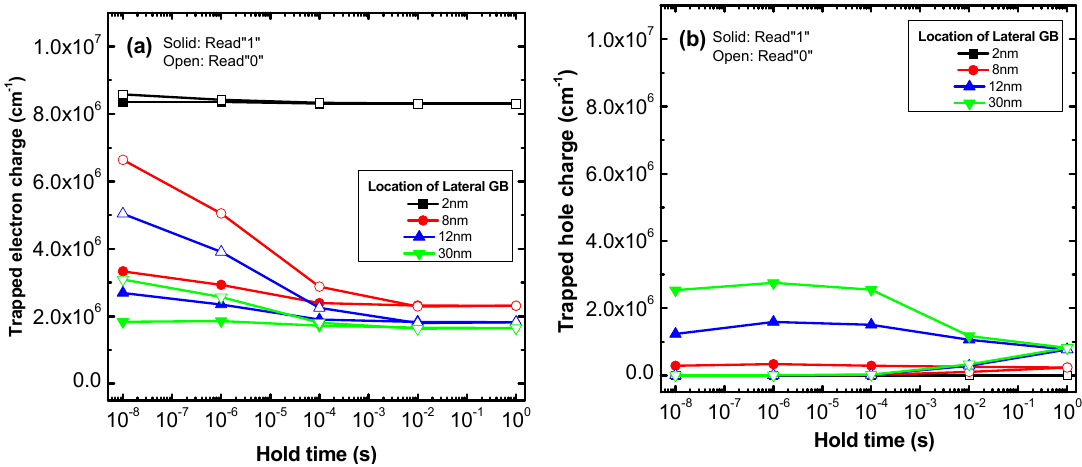
Figure 4. Trapped ( a ) electron and ( b ) hole charge of poly-Si 1T-DRAM devices with varied lateral GB locations according to the hold time in the Read “1” and Read “0” operations.